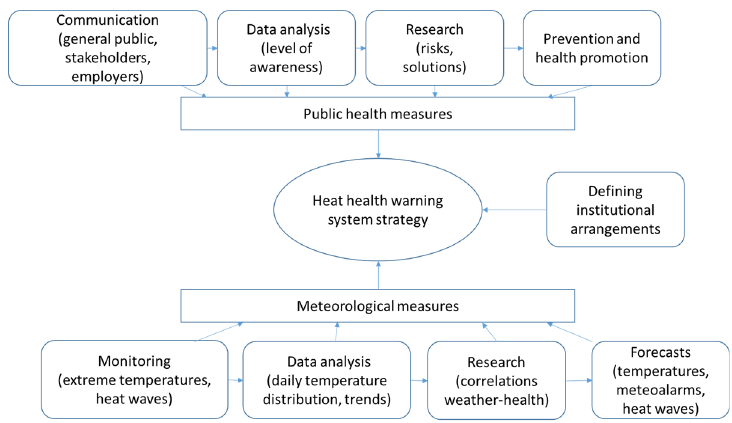
Figure 1. The scheme of a heat health warning system strategy based on the meteorological and public health measures.